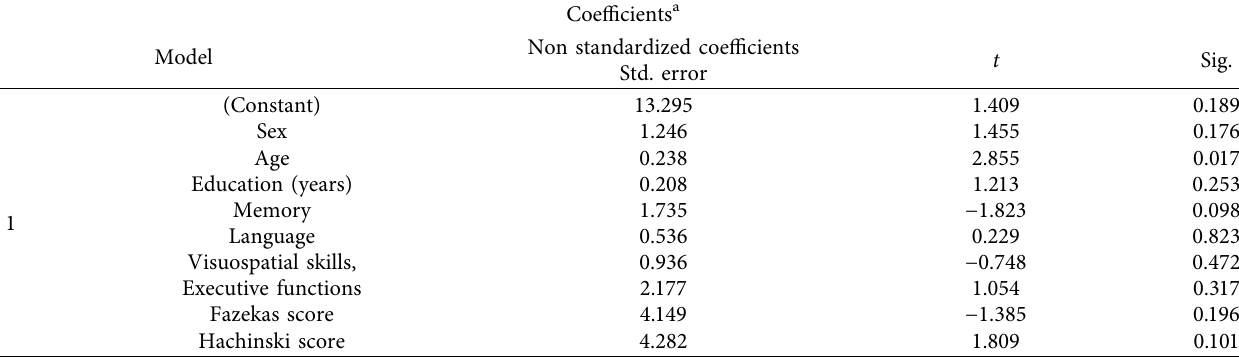
Table 3: Coefficient values for MXD.